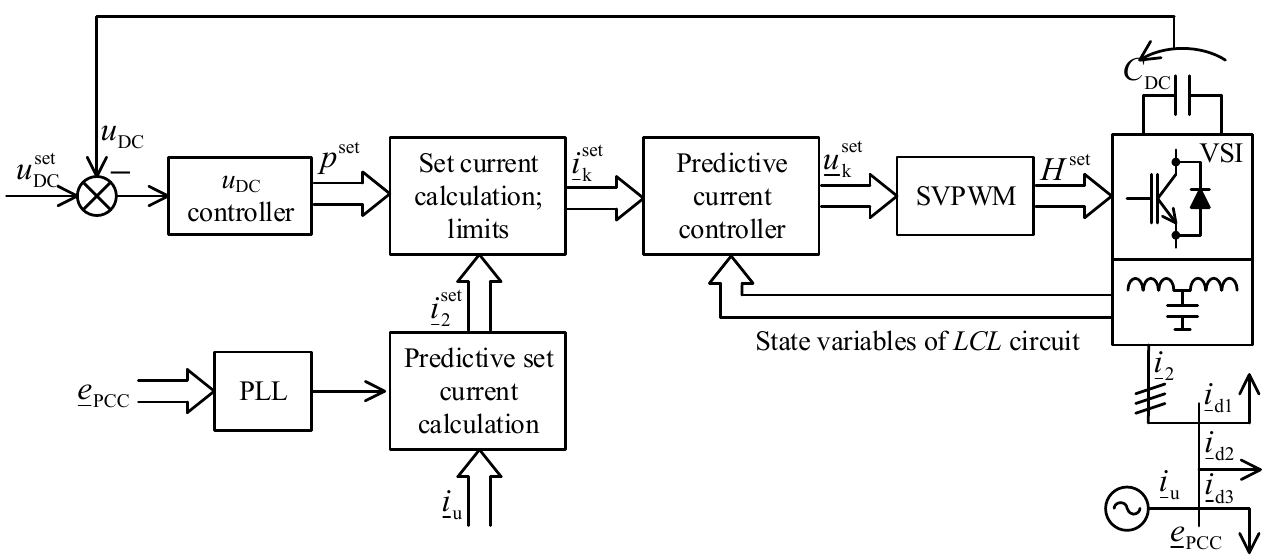
Figure 2. Block diagram of the control system.